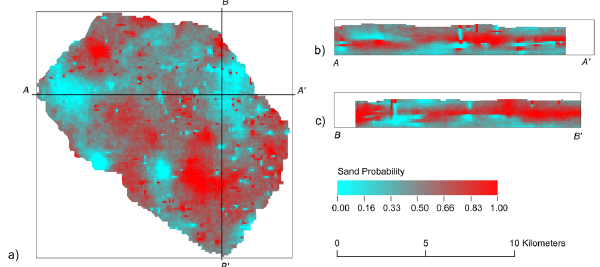
Fig. 5. E-type estimation maps generated from 100 SNESIM real- izations. (a) Horizontal view at an elevation of − 10ma.s.l.; (b) X-Z cross section with Z exaggeration of 15; (c) Y-Z cross section with Z exaggeration of